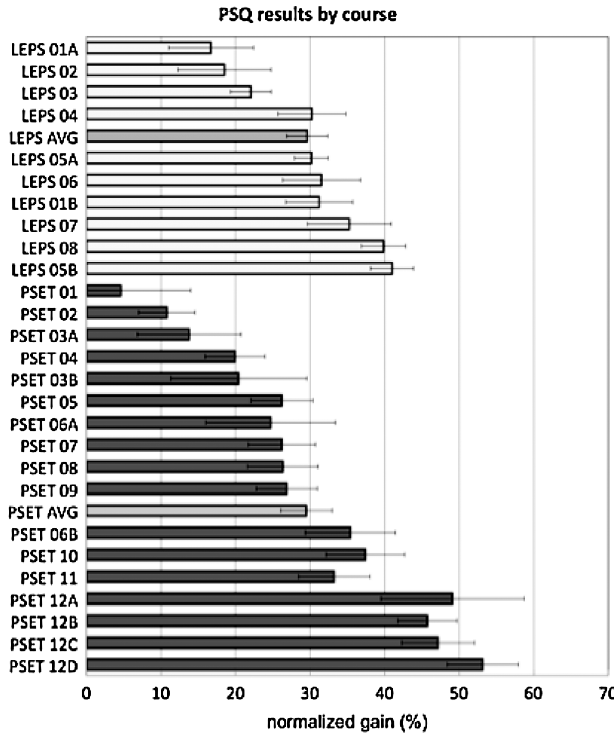
FIG. 16. Average normalized course gain on PSQ. Error bars are standard error of the mean. Letters in the course identifiers indicate different courses taught by the same